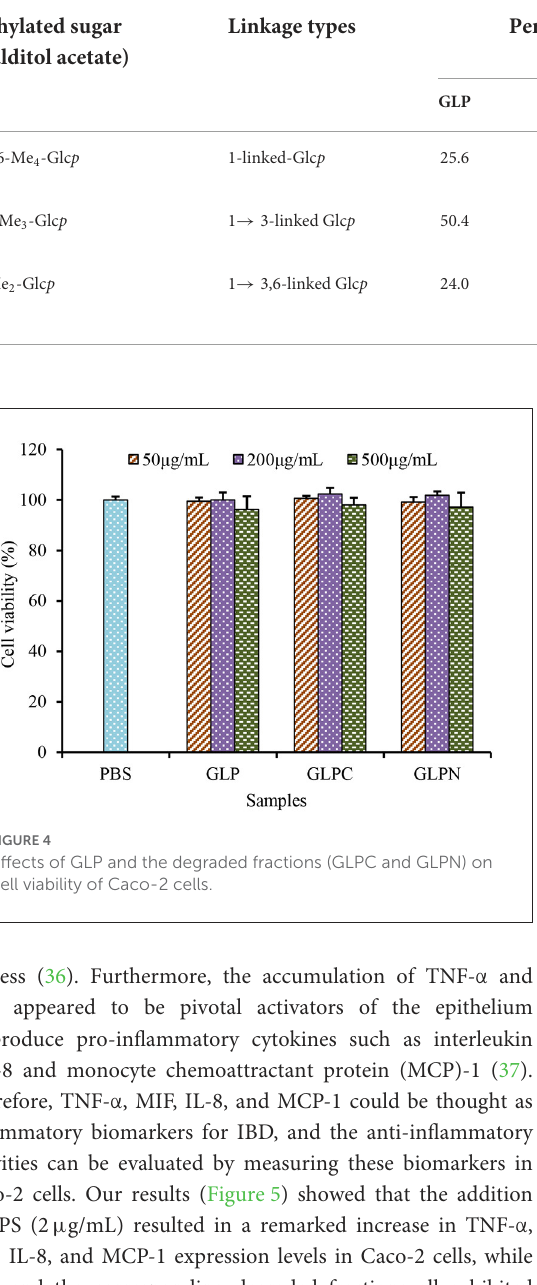
TABLE 2 Methylation analysis of polysaccharide fractions.